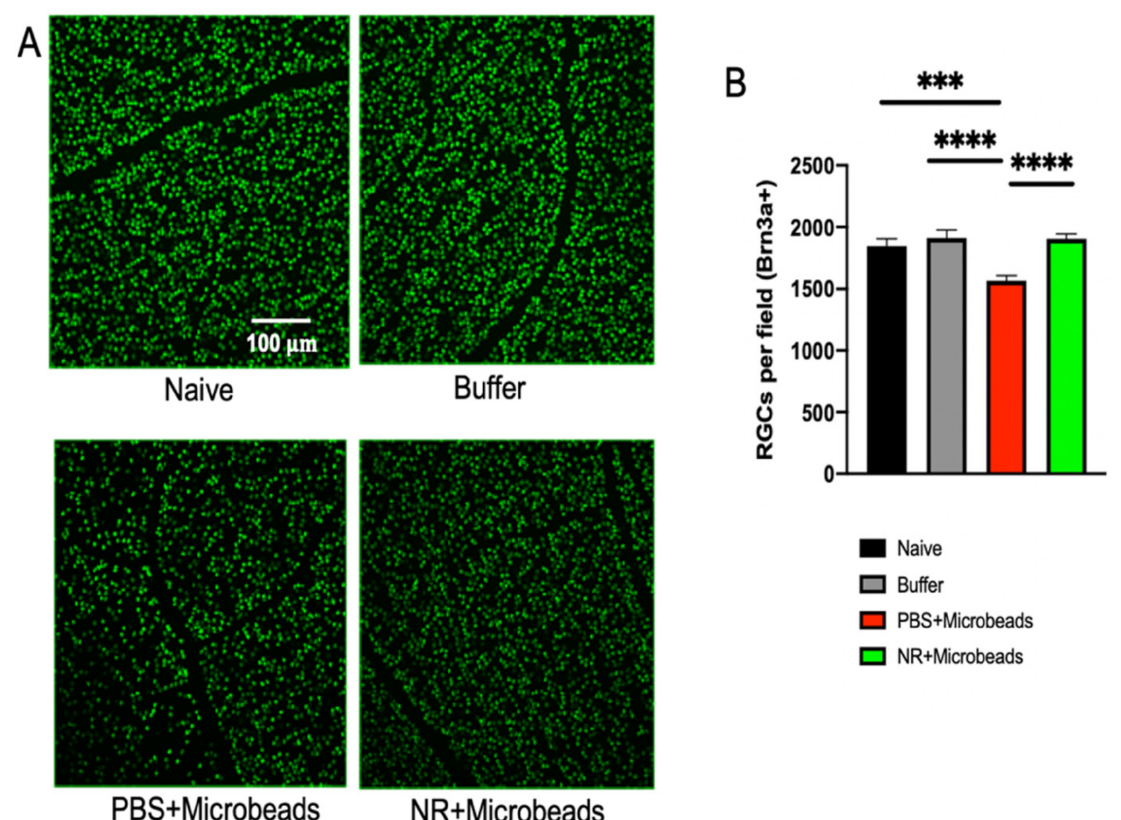
Figure 6. NR treatment prevents RGC loss following microbead injection. ( A ). Representative images of retina flatmounts immunostained for Brn3a+ from each cohort; green is Brn3a+ immunosignal and is presumed to stain RGCs. Treatment groups are as described in Figure 5 legend. ( B ). Mean number of RGCs per field for each treatment group. RGC numbers were significantly lower in mice systemically injected with PBS and intracamerally injected with microbeads (red) compared to naïve eyes (black) or eyes injected with microbead buffer (gray). Conversely, mice systemically injected with NR and intracamerally injected with microbeads (green) had a mean number of RGCs significantly greater than mice that had undergone ONC but had been injected with PBS (red). *** p < 0.001, **** p < 0.0001 by one-way ANOVA Newman-Keuls test. N = 10–19 mice/group. Error bars represent